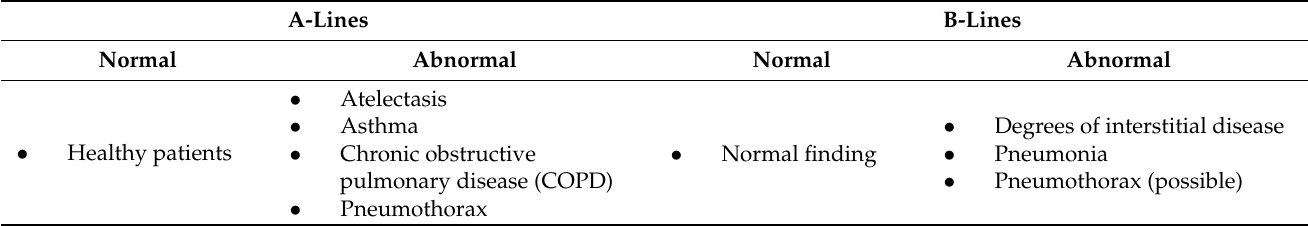
Table 1. LUS artifact dichotomy. Modified from Di Serafino et al.